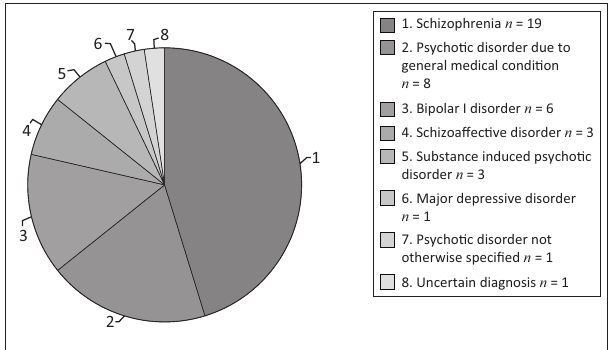
FIGURE 1: Distribution of primary psychiatric diagnoses ( n = 42).